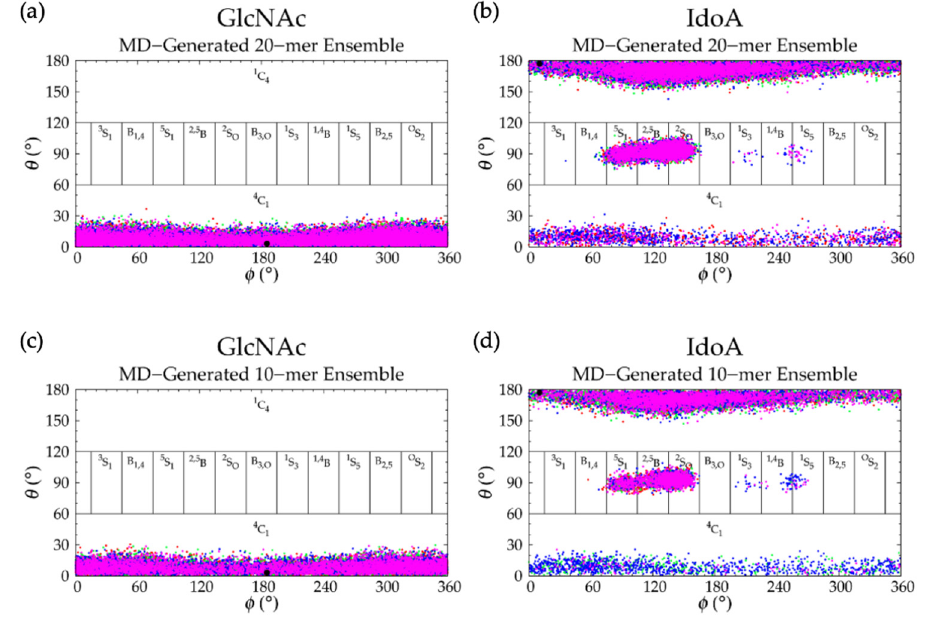
Figure 20. Cremer–Pople data for MD-generated nonsulfated heparan ensembles: ( a ) GlcNAc and ( b ) IdoA in the 20-mer and ( c ) GlcNAc and ( d ) IdoA in the 10-mer; geometries from the four sets of each ensemble are represented by red, green, blue, and magenta dots, respectively and the force-field geometry is represented by a single large black dot; Cremer–Pople parameters ( φ , θ ) for all rings in every tenth snapshot from each ensemble were plotted (i.e., 10 rings × 1000 snapshots per run × 4 runs = 40,000 parameter sets for the 20-mer and 20,000 parameter sets for the 10-mer). The primary goal of our algorithm is to predict backbone conformations of long GAG chains, which requires that (1) monosaccharide rings in GAG 20-mers behave independently in MD simulation and (2) contributions of ring puckers to backbone flexibility match those expected in nonsulfated heparan polymers in aqueous solution. There did not appear to be any interdependency between adjacent rings, suggesting that monosaccharide rings behave independently in nonsulfated heparan 20-mer MD simulations. To determine the effects of IdoA ring puckering on polymer backbone conformations, end-to-end distances of 20-mer conformations containing monosaccharides in (1) boat and skew-boat conformations that caused a kink in the polymer chain and (2) 2 S O conformations, were analyzed (Figure S30). The end-to-end distance distribution of 20-mer conformations with the ring puckers that caused a kink was similar to that of the average of the four MD runs and the most probable end-to-end distance was only 1 Å lower in conformations with ring puckers that caused a kink, suggesting that boat and skew-boat conformations that introduce a kink do not necessarily give less compact 20-mer conformations, and thus are not major factors contributing to backbone flexibility. The distribution curve of 20-mer conformations with 2 S O IdoA ring puckers and that of 20-mer conformations with non- 2 S O boat/skew-boat puckers that caused a kink were qualitatively similar to that of the full 20-mer MD ensemble, but had additional peaks in probability of higher end-to-end distances. These findings suggest that IdoA boat/skew-boat conformations are associated with the full range of 20-mer backbone conformations in MD simulations with only a slight tendency toward extended 20-mer conformations. Therefore, the proportion of IdoA 2 S O conformations likely does not have a major effect on nonsulfated heparan 20- mer backbone flexibility. Next, glycosidic linkage dihedral free energies Δ G ( ϕ , ψ ) were examined (Figure 21 and Table 8). IdoA α 1-4GlcNAc glycosidic linkages sampled primarily − ϕ , + ψ with secondary basins in − ϕ , − ψ and GlcNAc α 1-4IdoA glycosidic linkages sampled conformations in a single basin (+ ϕ , + ψ ). We compared our results to those of an NMR and force field study that performed two sets of MD on each of